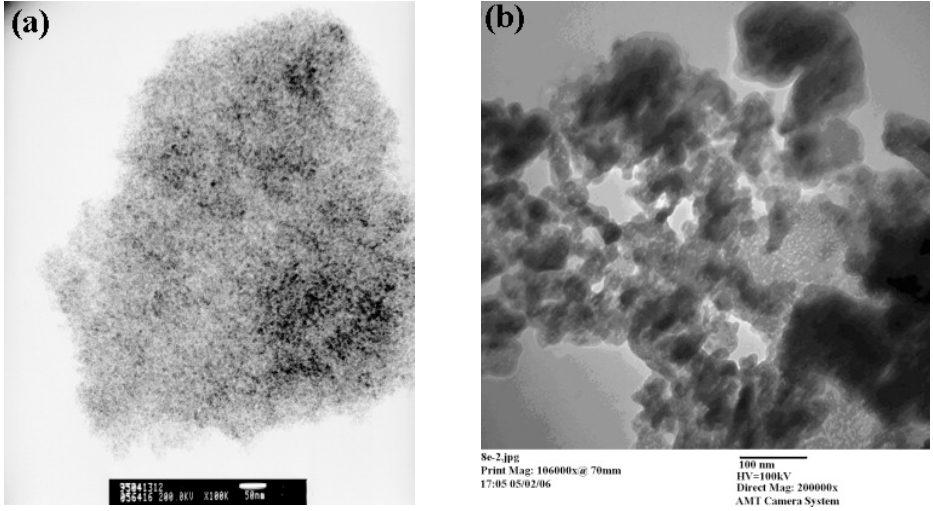
Figure 3. TEM image of ( a ) M-TiO 2 and ( b ) doped M-TiO 2 . Reprinted with permission from reference [23]; Copyright 2018,